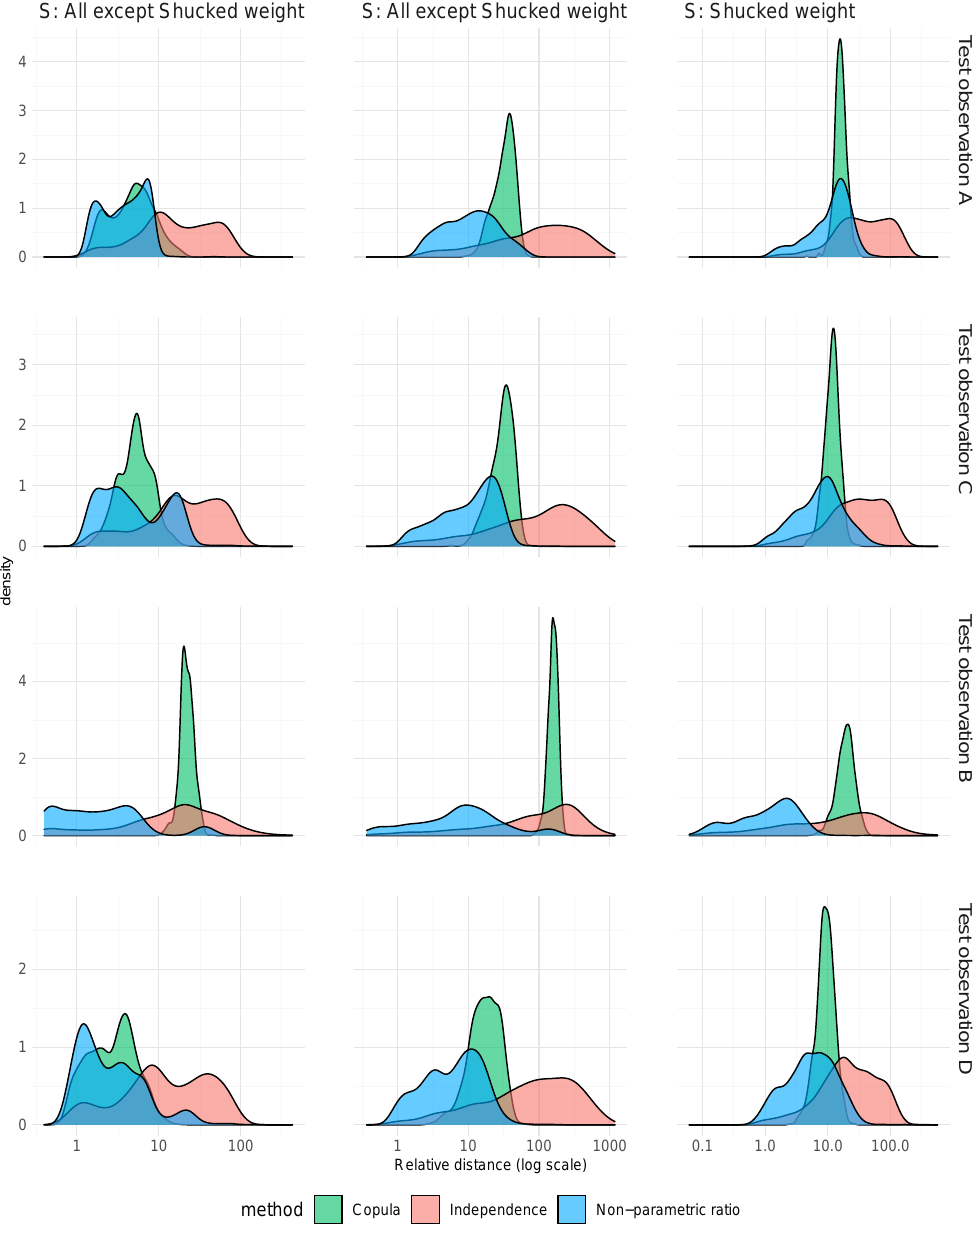
Figure 7: Probability densities of mean Mahalanobis distances for three different conditional distributions and three different individuals. See the text for a further